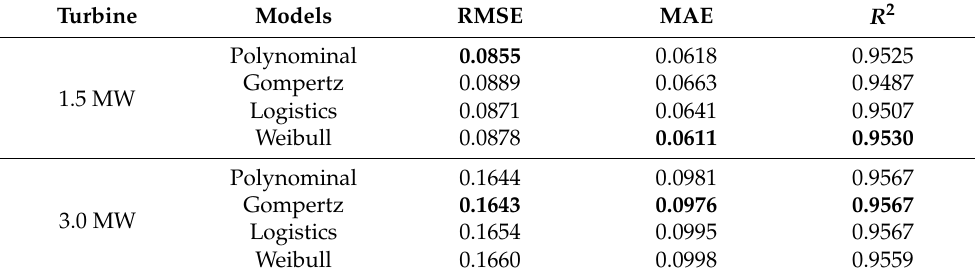
Table 1. Goodness-of-Fit Analysis of Different Parametric